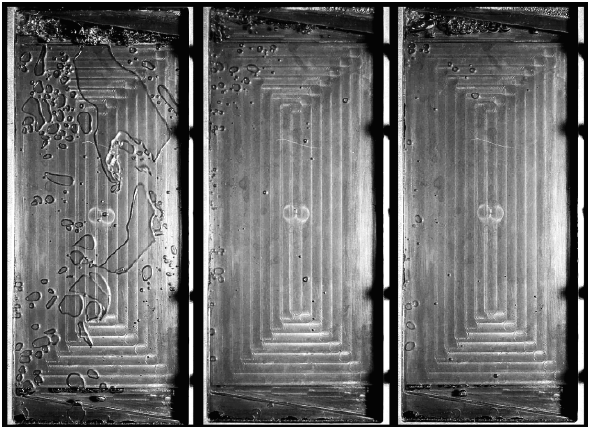
Figure 7. Increased generation of vapor along with a decrease in the mass flow rate of the test fluid resulting from the insufficient efficiency of a vapor-liquid lifting (water, minigap 1 mm): Left —filling = 16.6%; middle —filling = 100%; right —filling > 100%.